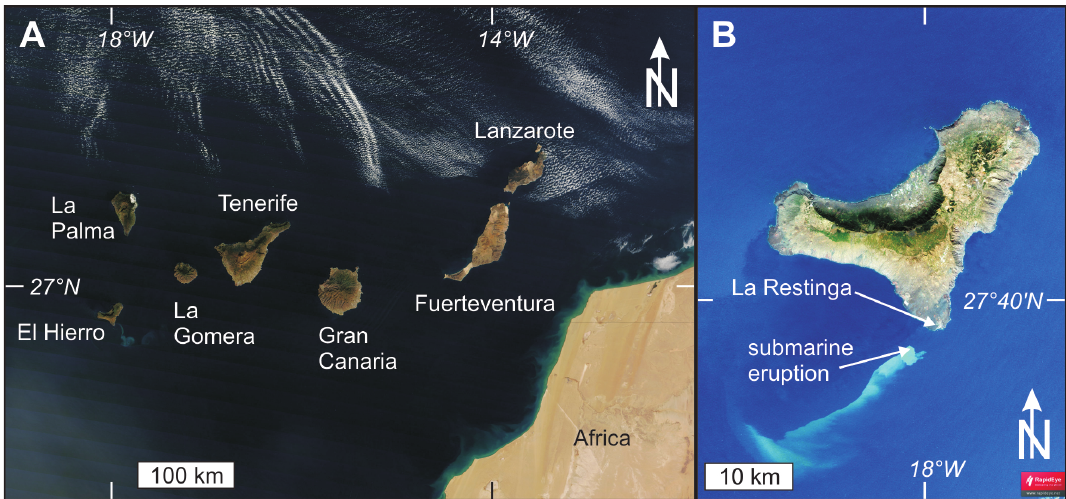
Fig. 1. Satellite images of (A) the Canary Islands west off the coast of Africa. True colour image captured by the Moderate Resolution Imaging Spectroradiometer (MODIS) aboard the Terra satellite on 21 December 2011. The stain of the ocean caused by the submarine eruption can be seen SSE of El Hierro. Image credit: Jeff Schmaltz MODIS Land Rapid Response Team, NASA GSFC. (B) True color RapidEye satellite image of El Hierro and the discolouration of sea water caused by the submarine eruption on 13 October 2011. Image credit: Rapid